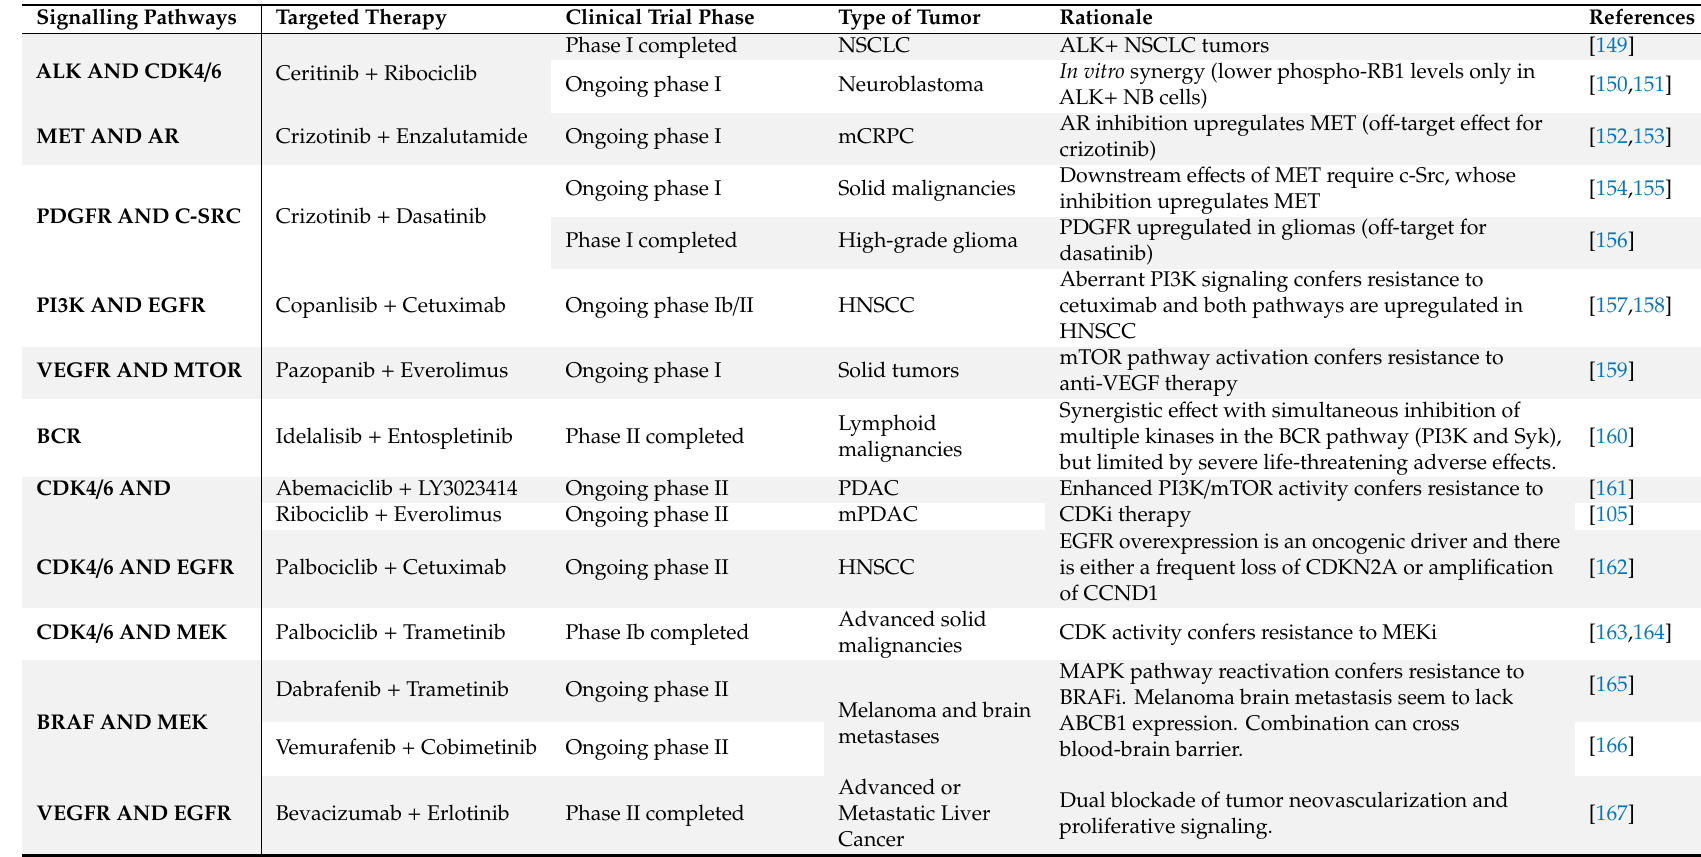
Table 4. Clinical trials with combinations between targeted therapies in which the first inhibit resistance mechanisms of the